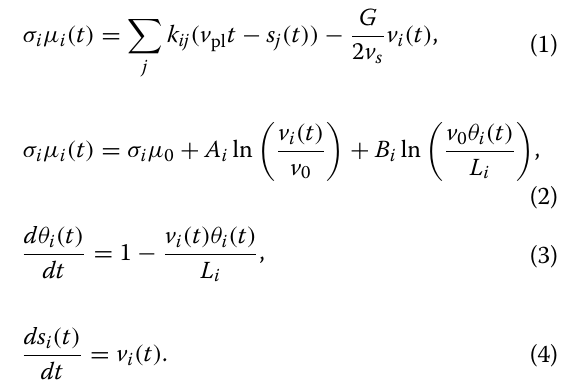
Temporal evolutions of fault slips are simulated by solving the physics-based governing equations at each subfault, which consist of a quasi-dynamic equation of motion in an elastic medium (Rice 1993) and the RSF law with an aging law as the evolution of state variables (Diet- erich 1979; Ruina 1983):